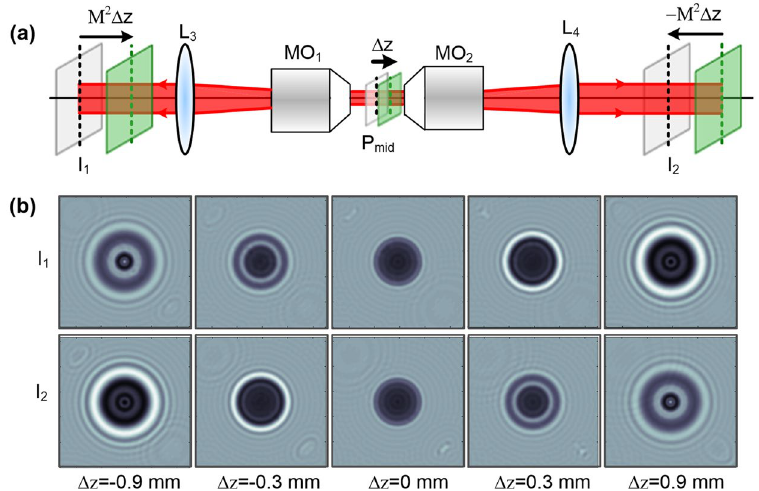
Figure 2. Schematics of autofocusing of OV-DHM. ( a ) Illumination and imaging schematics of OV-DHM; P mid denotes the middle plane of telescope system MO 1 -L 3 and MO 2 -L 4 ; M denotes the magnification of the two telescope systems. ( b ) The simulated images of a sample on CCD plane when it moves from left to right with Δ z = − 0.9 mm, − 0.3 mm, 0 mm, 0.3 mm and 0.9mm from the middle plane P mid